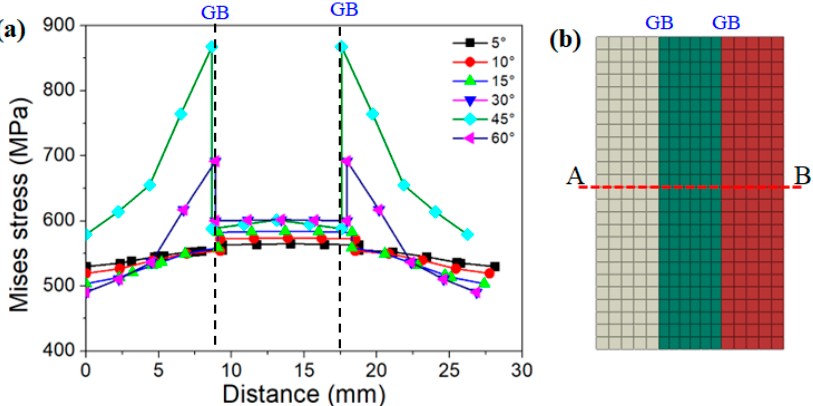
Figure 8. Stress distribution along trace line (A-B) of columnar grains with different misorientation angles: ( a ) stress distribution curves; ( b ) selected trace line A-B. angles: ( a ) stress distribution curves; ( b ) selected trace line